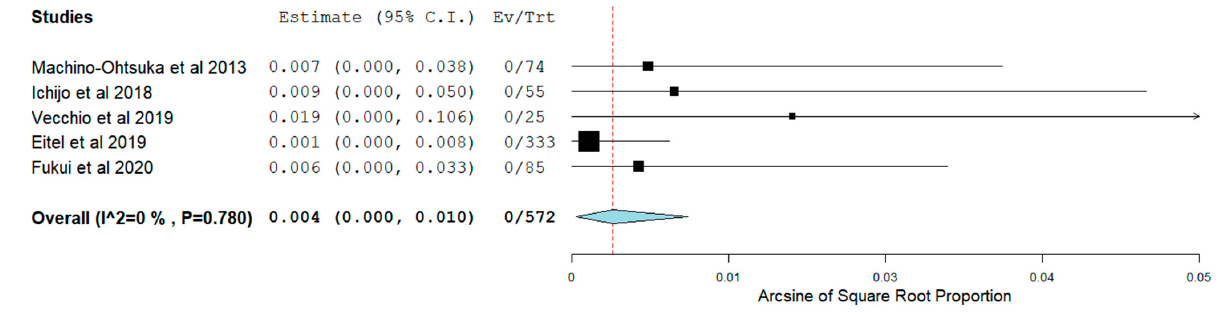
Figure 2. Major vascular complications in patients with HFpEF.